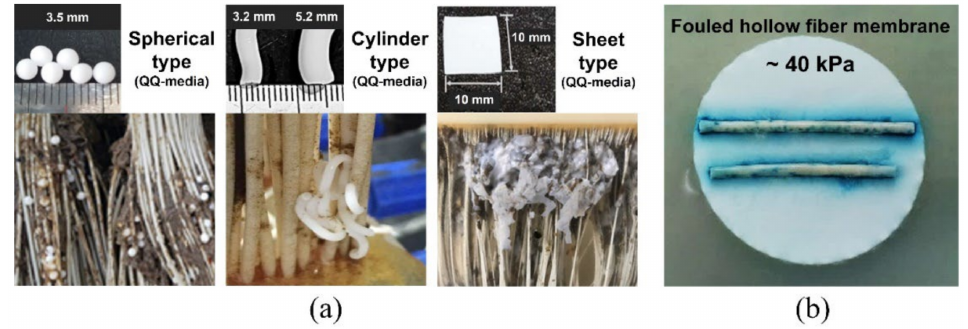
Figure 1. Examples of ( a ) various types (bead, cylinder, and sheet) of quorum quenching (QQ) media trapped between HFMs reprinted from references [15,21] by permission of the publisher (Taylor & Francis Ltd.). ( b ) Detection of the bacterial quorum sensing (QS) signal AHLs present at the surface of the fouled HFM